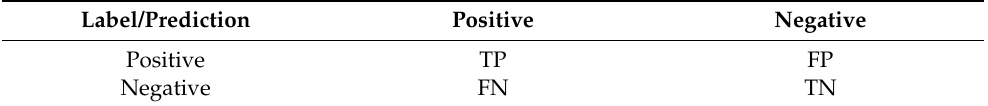
Table 3. Matrix of classification metrics.